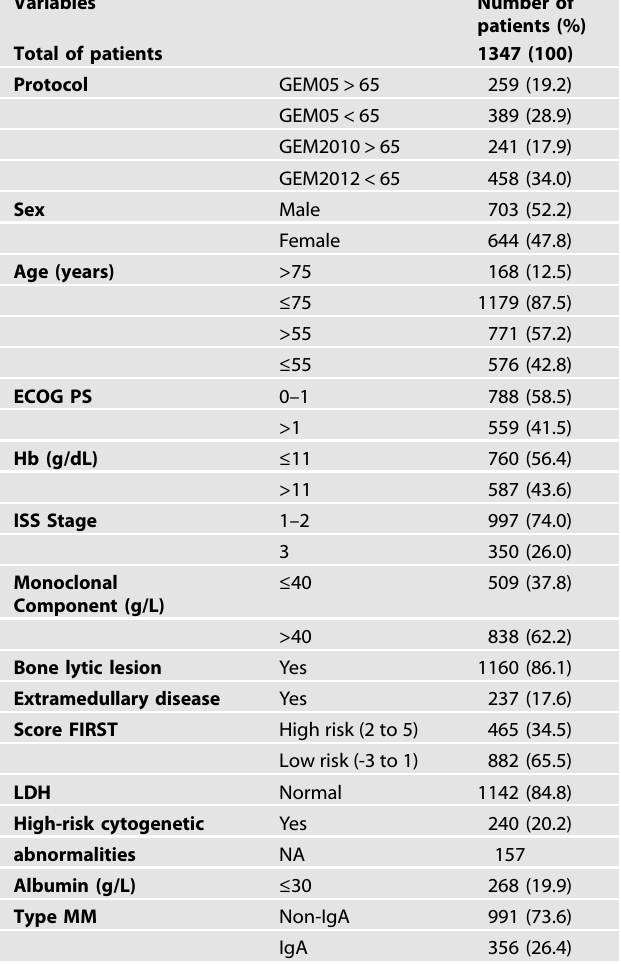
Table 1. Main clinical characteristics of the